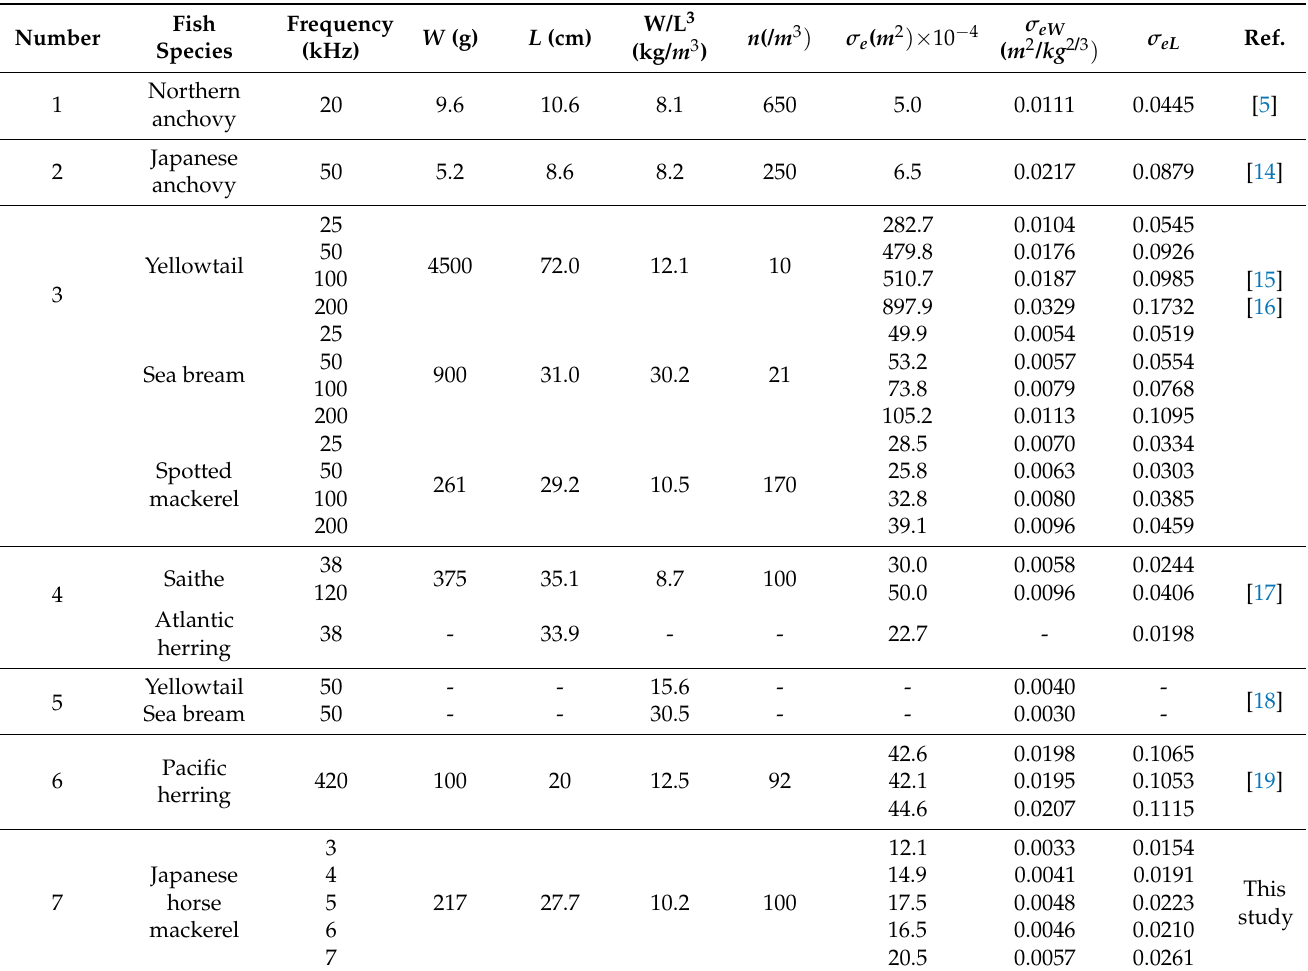
Table 3. Summary and comparison of the attenuation experiments in fish schools; fish species, frequency, wet weight ( W ), total length ( L ), relationship W - L ( W/L 3 ), number density ( n ), extinction cross-section ( σ e ), normalized extinction cross-section of W ( σ eW ) and L ( σ eL ), and references from previous and present